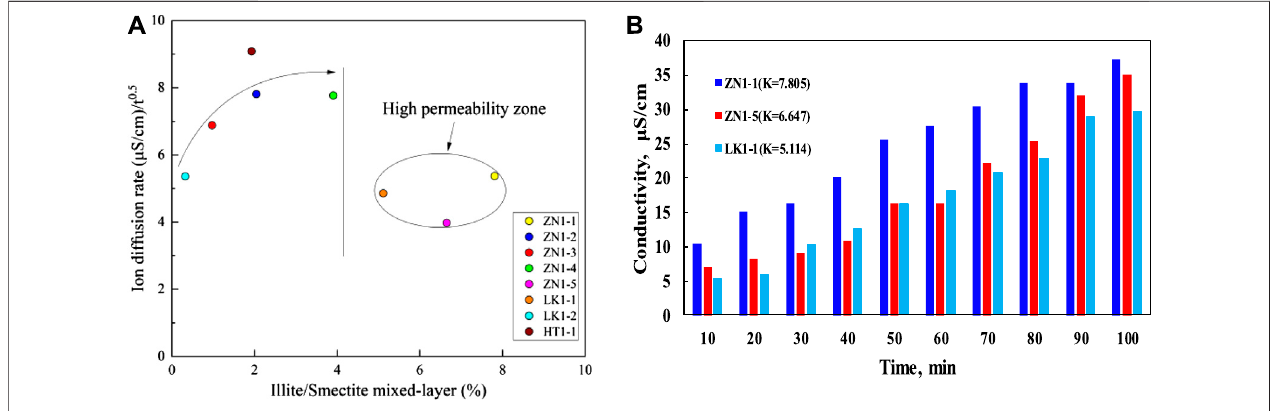
FIGURE 16 | The effects of permeability on ions diffusion (A) curves of ions diffusion rate vs. permeability and (B) characteristics of high permeability zone.